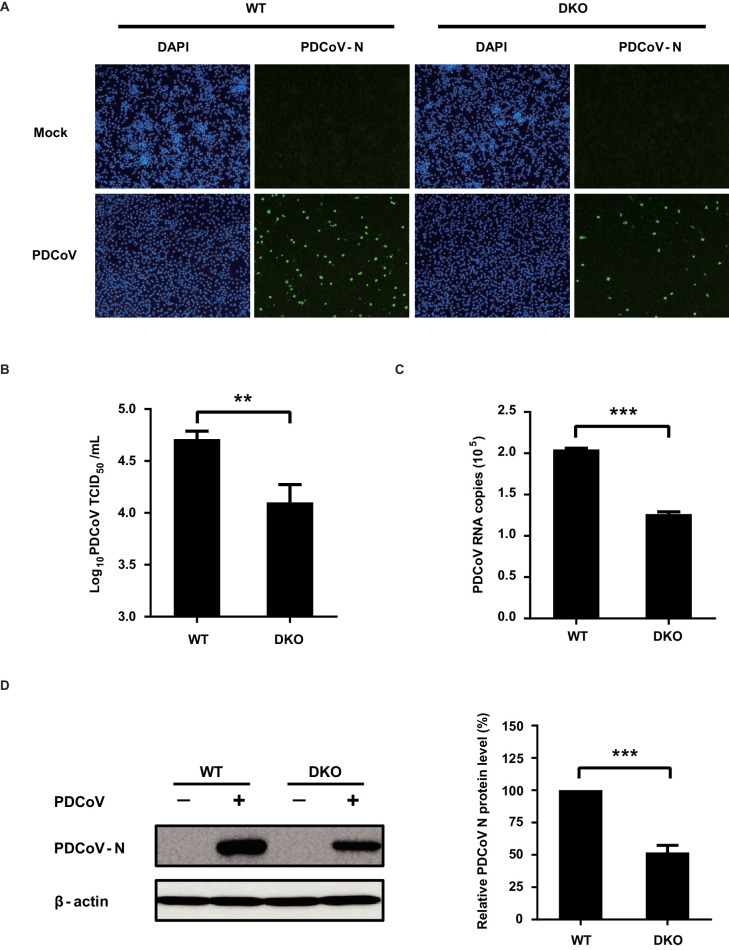
PAMs of DKO pigs exhibit reduced susceptibility to PDCoV.(A) WT PAMs and DKO PAMs were infected or mock-infected with PDCoV (MOI = 10); at 24 hpi, PDCoV-N-specific fluorescence signals were detected by IFA. (B) WT PAMs and DKO PAMs were infected with PDCoV (MOI = 10); at 24 hpi, cells were collected and the viral titer was determined by TCID50 assays (in LLC-PK1 cells). (C, D) WT PAMs and DKO PAMs were infected with PDCoV (MOI = 10); at 24 hpi, cells were harvested and analyzed using qRT-PCR (C) and western blot assays (D). The PDCoV-N protein level was quantified by ImageJ. Data are expressed as the mean ± SD. Statistical significance was determined by Student’s t test; ns, p>0.05; *p<0.05; **p<0.01; ***p<0.001.Figure 4—figure supplement 1—source data 1.The TCID50 detection of PDCoV titer in PAMs.Figure 4—figure supplement 1—source data 2.The qRT-PCR detection of PDCoV RNA copies in PAMs.Figure 4—figure supplement 1—source data 3.The western blot detection of the relative PDCoV-N protein level in PAMs.